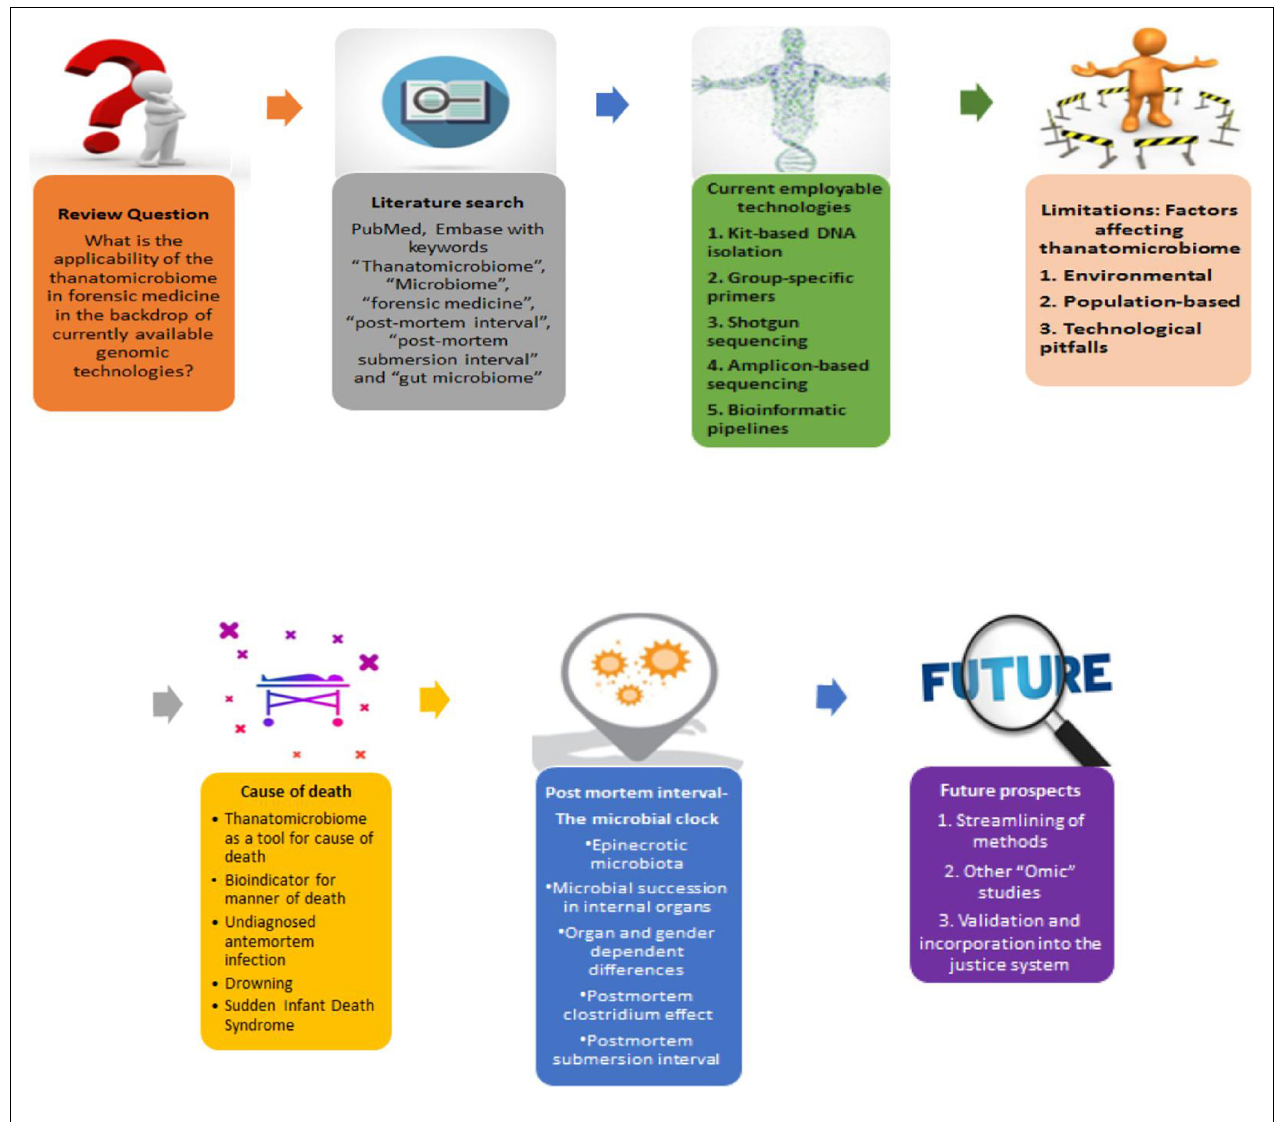
FIGURE 1 | A schematic roadmap of the